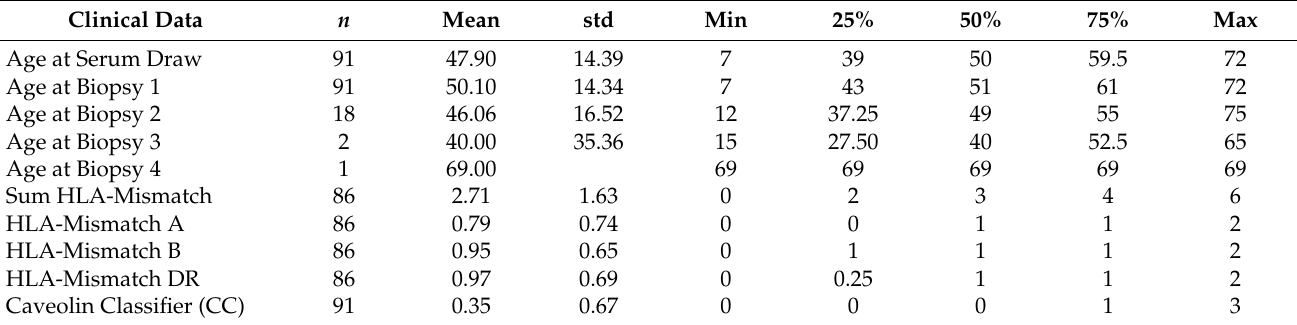
Table 1. Descriptive statistics of patients’ clinical